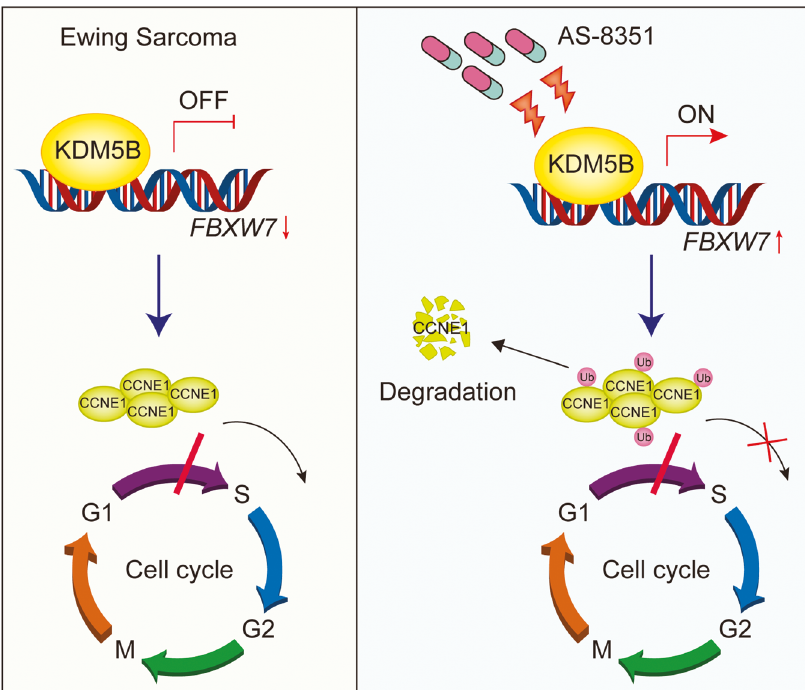
Fig. 7 Schematic diagram of KDM5B-mediated regulation for Ewing sarcoma proliferation by the FBXW7/CCNE1 axis. (Left) In Ewing sarcoma cells, KDM5B overexpression inhibits FBXW7 transcription by demethylation of H3K4me3 at the promoter region, blocking the degradation of CCNE1 and accumulating CCNE1 protein, leading to acceleration of cell cycle process and cell proliferation of Ewing sarcoma. (Right) Epigenetic drug AS-8351 suppresses the function of KDM5B and elevates H3K4me3 level at the promoter region of FBXW7 gene, then up-regulates FBXW7 and enhances CCNE1 degradation, resulting in cell cycle arrest and tumor growth